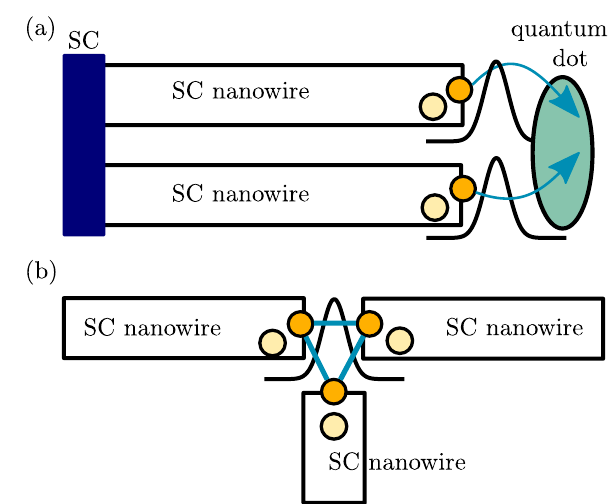
Figure 10: (a): Braiding in a measurement-based device of parallel superconducting nanowires coupled to a quantum dot. Only one of each pair of quasi-Majorana states effectively couples across the smooth barrier to the quantum dot (blue arrows). (b): Tri-junction setup for Coulomb-assisted braiding with quasi-Majorana states. From the pairs of quasi-Majoranas in each nanowire, only one couples across the tunnel barrier to the other two quasi-Majoranas (blue